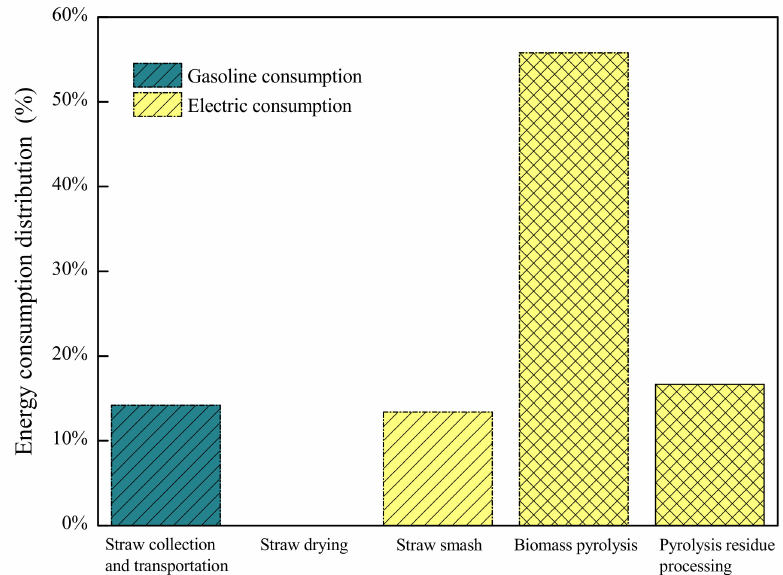
Figure 5. Distribution of additional energy consumption for the non-phase-transition drying pyroly- sis and mass conversion